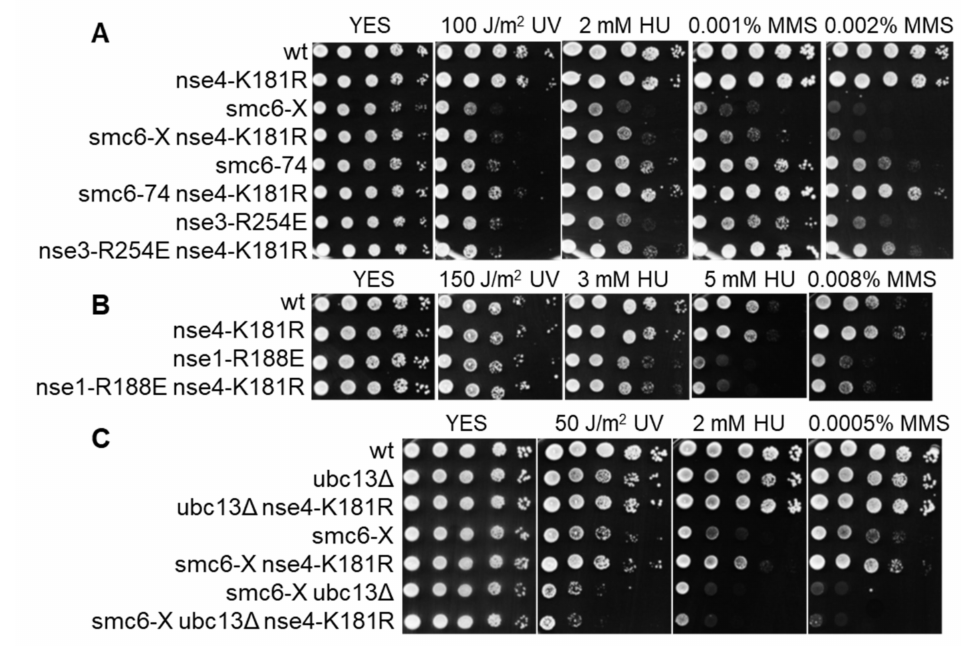
Figure 4. Nse4-K181R mutation partially suppresses the sensitivities of smc6-X , smc6-74 , and nse3- R254E to DNA-damaging agents and HU. ( A ) Sensitivity of depicted smc5/6 mutants to UV, HU, and MMS is partially suppressed by nse4-K181R . ( B ) Nse4-K181R does not suppress the sensitivity of the nse1-R188E strain. ( C ) Suppression of smc6-X sensitivity by nse4-K181R is dependent on Ubc13 . The indicated S. pombe strains were grown to OD 600 ~ 1, tenfold serially diluted, spotted onto rich media with specified amounts of DNA-damaging agents, and incubated at 28 ◦ C for 3